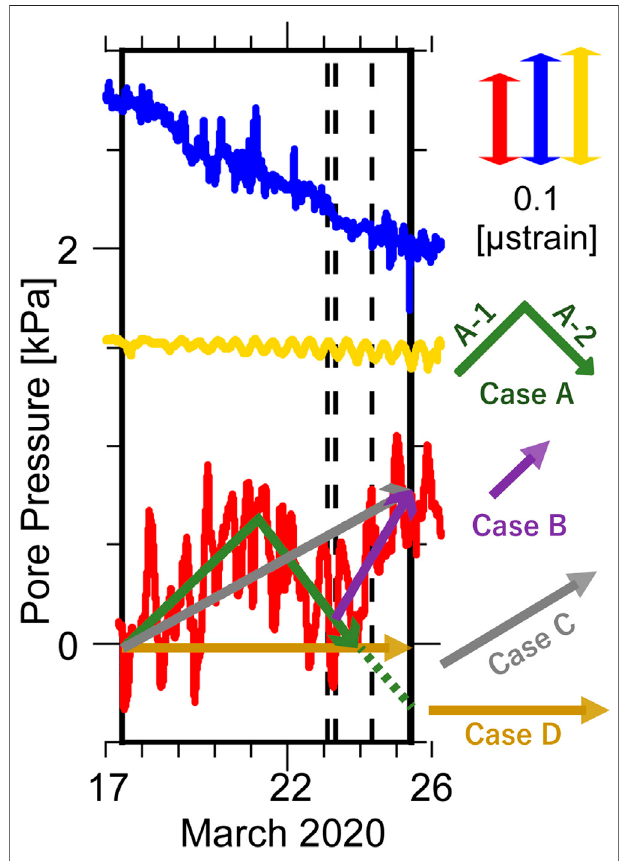
FIGURE 6 | Close up of the time history of the pore pressure ( Figure 3 ) during the event, where the onset/termination time is determined by Figures 5A,B . Arrows indicate possible cases for the time histories of crustal deformation component at C0010 determined by regression lines (see text). The dotted lines represent additional Cases A-2+ and C+ as listed in Table 4 .